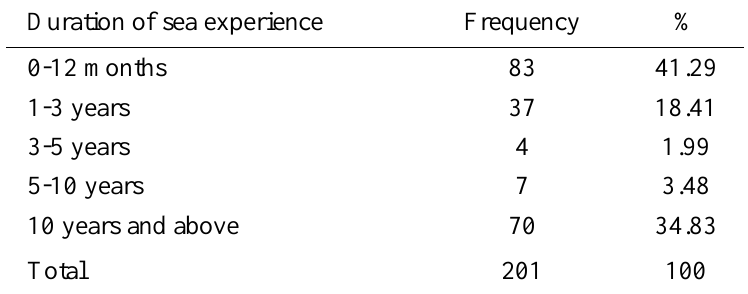
Table 5. Distribution of participants according to sea